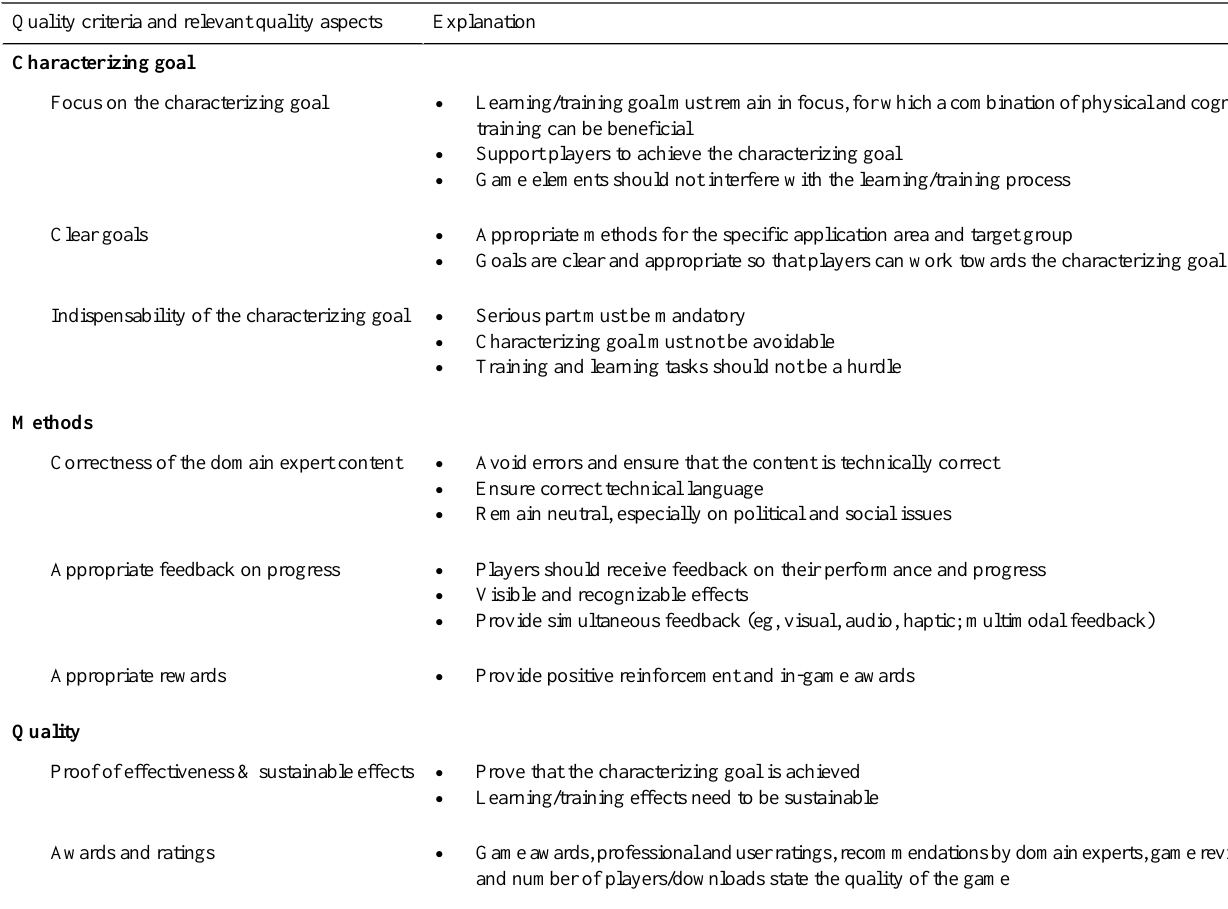
Table 1. Summary of quality criteria for the serious